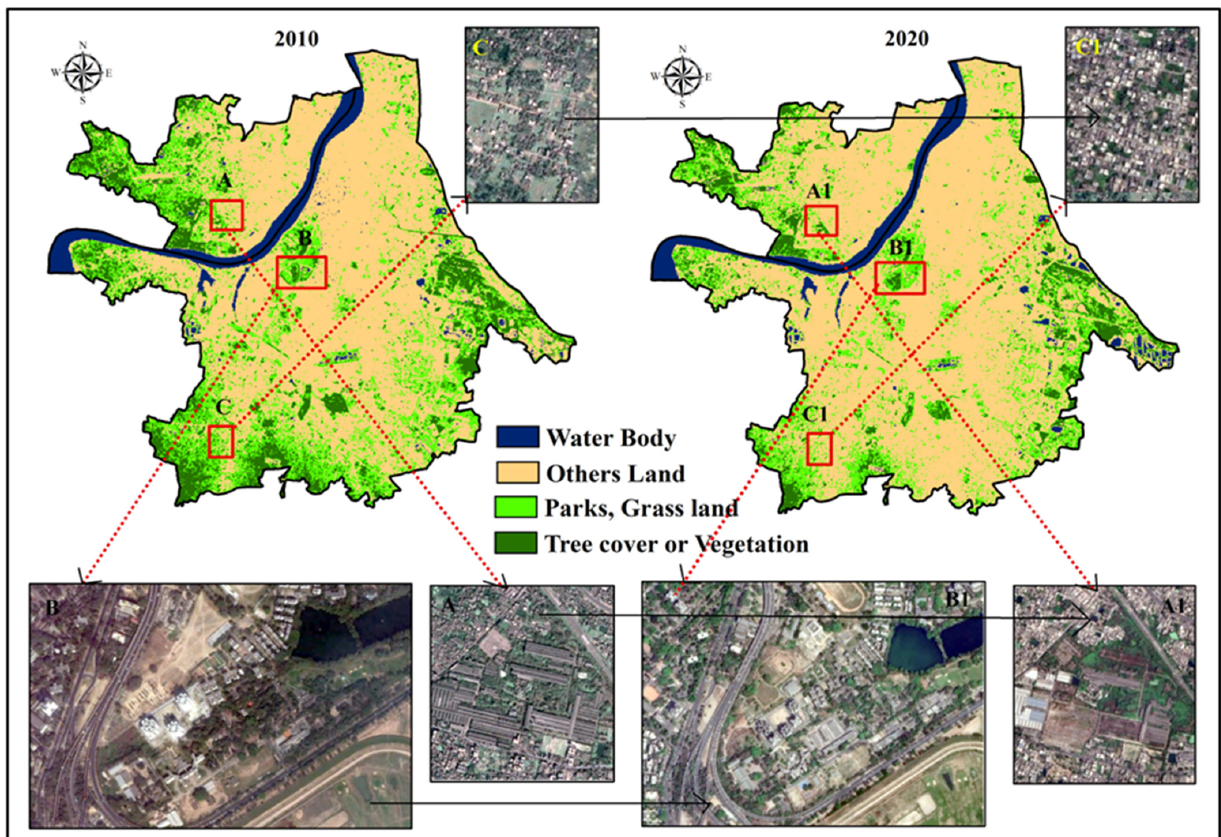
Figure 5. Land use and land cover (LULC) classification in 2010 and 2020 in West Bengal (Kolkata and Howrah).